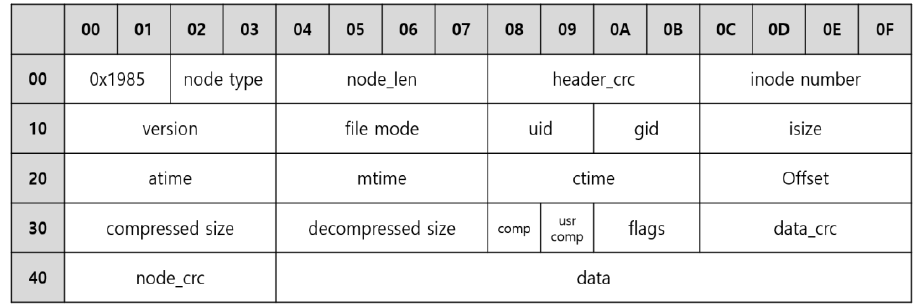
Figure 10. PCB of DCU.